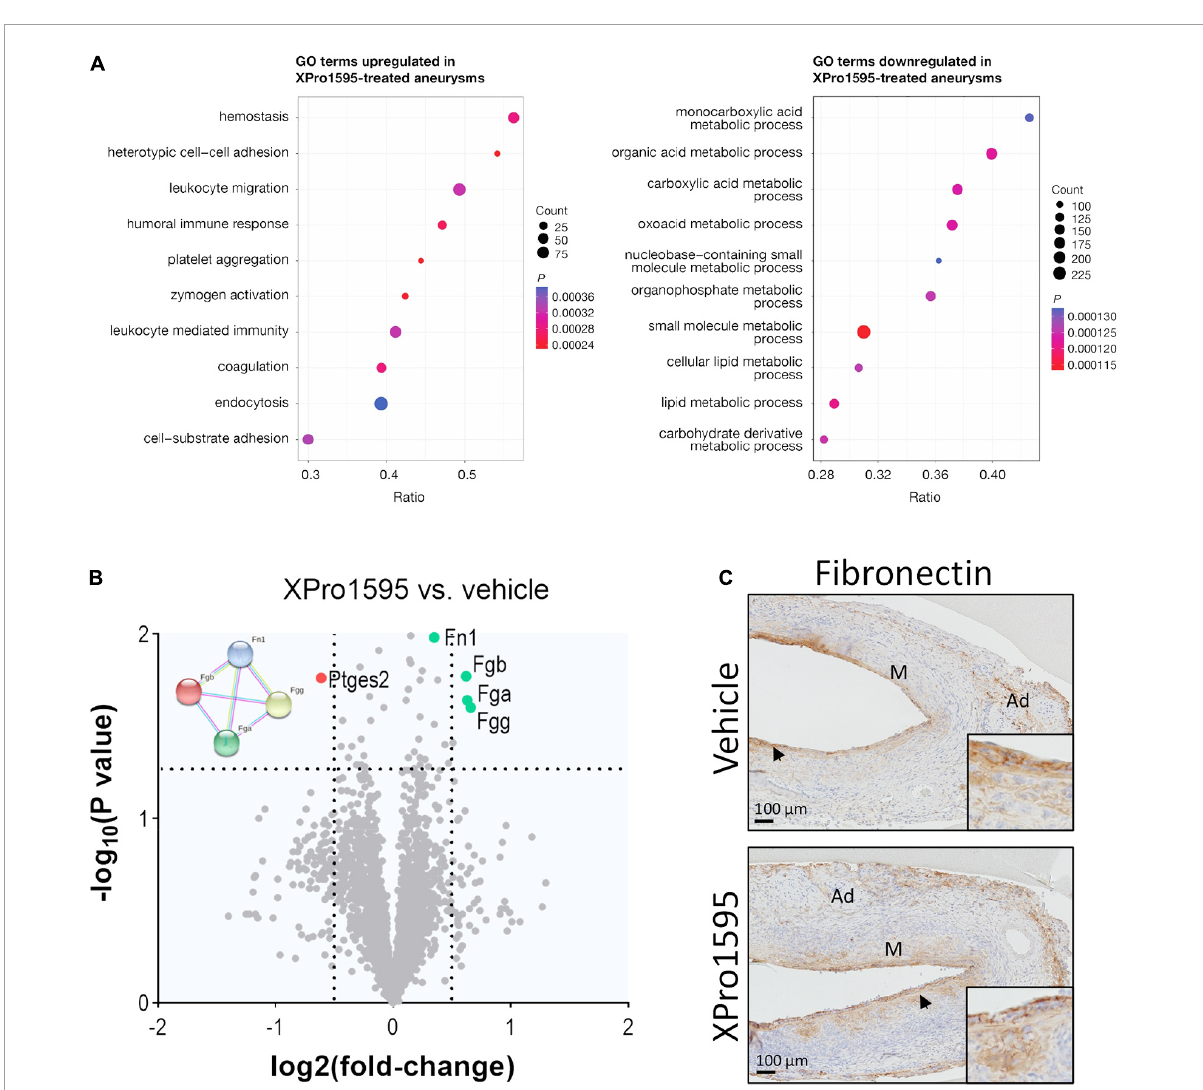
FIGURE5 The fibronectin/fibrinogen complex is upregulated in aneurysms after inhibition of solTNF by XPro1595 . (A) Dot plots show the top 10 enriched biological function terms from proteins up- (left) or down-regulated (right) in PPE-induced aneurysms from XPro1595-treated mice ( n = 7) vs. vehicle ( n = 6) at day 7. Dot size indicates number of proteins found to be regulated by XPro1595 for a given term. The ratio shows the proportion of a functional term covered by proteins regulated by XPro1595, and the dot color indicates the level of significance. (B) Volcano plot of aneurysmal proteins and their differential expression in aneurysms from XPro1595-treated mice vs. vehicle. Horizontal dashed line denotes a 0.05 cut-off p -value, and vertical dashed lines denote a log2(fold-change) of 0.5 in either direction. Fibronectin (FN1), fibrinogen chains FGA, FGB, and FGG and their protein-protein interactions are illustrated by use of the STRING resource (74), showing interactions determined experimentally (pink lines), from curated databases (blue lines), and/or from text-mining (yellow lines) (left upper corner of volcano plot). (C) Fibronectin contents in representative abdominal aortic aneurysmal tissue sections from mice infused with elastase and treated with XPro1595 (20 mg/kg) or vehicle ( n = 3–5). Black arrowheads indicate positive stained cells. Proteomics data were analyzed by unpaired t -test for each protein followed by fdr correction for multiple testing. M, media; Ad,